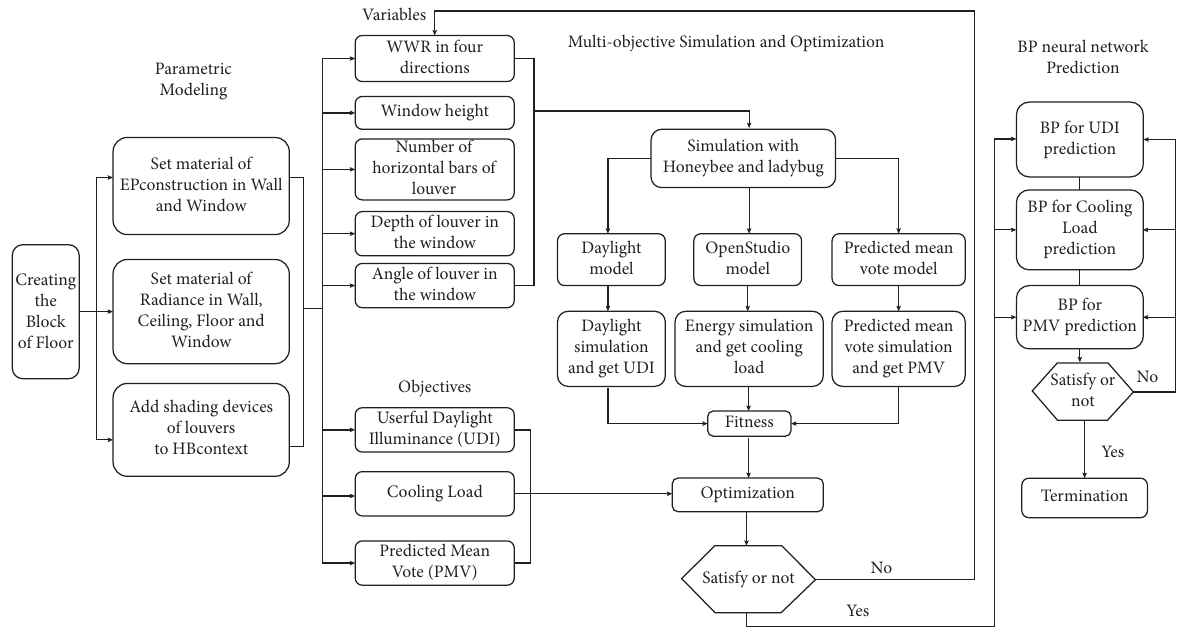
Figure 6: Optimization process of the simulation.